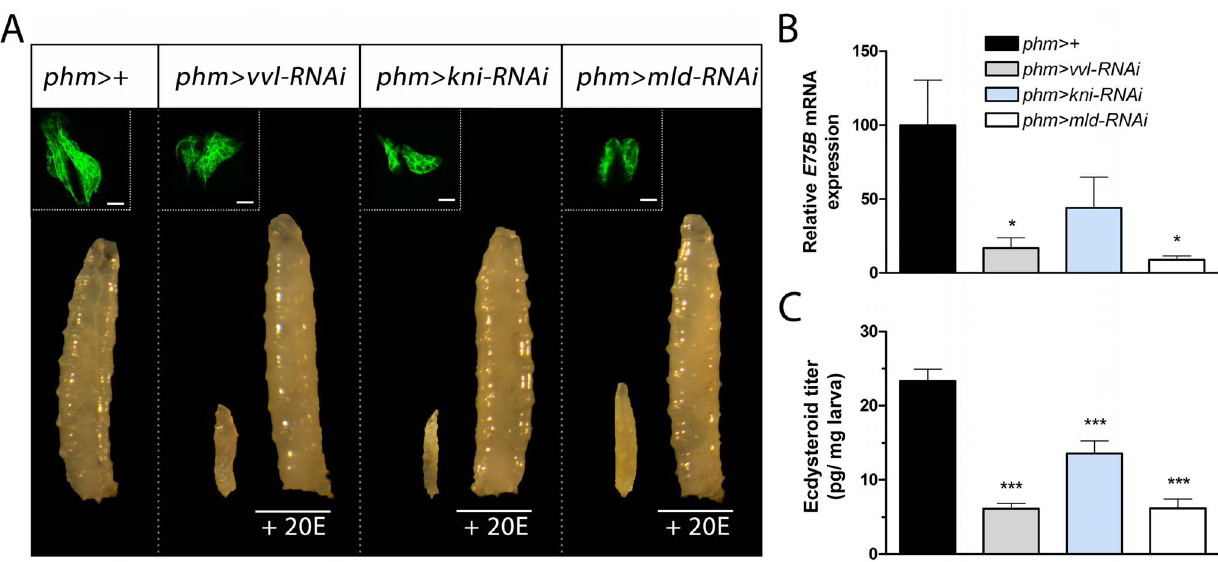
Figure 2. Knock down of vvl , kni and mld in the PG results in developmental arrest and reduces ecdysteroid levels. (A) RNAi mediated knock down of vvl , kni or mld in the PG using a PG specific driver ( phm . ) results in developmental L1 arrest for phm . vvl-RNAi and phm . mld-RNAi and L1 and L2 arrest for phm . kni-RNAi larvae. The morphology of the cells in the PG (GFP; green in the top left corner) is normal in phm . GFP , vvl- RNAi , phm . GFP , kni-RNAi and phm . GFP , mld-RNAi animals 36 hours AEL (scale bars, 20 m m). Supplying phm . vvl-RNAi , phm . kni-RNAi and phm . mld- RNAi larvae with 20-hydroxyecdysone (20E) rescues the developmental arrest. (B) Ecdysone levels, as measured by the ecdysone inducible gene E75B , is reduced in the mid-first instar (36 hours AEL) by knock down of vvl , kni or mld in the PG. (C) Ecdysteroid levels measured by ELISA confirm that L1 larvae with reduced expression of vvl , kni or mld in the PG have low levels of ecdysteroids 36 hours AEL compared to the control. Error bars indicate s.e.m. (n=4). * P , 0.05, *** P , 0.001, versus the phm . +